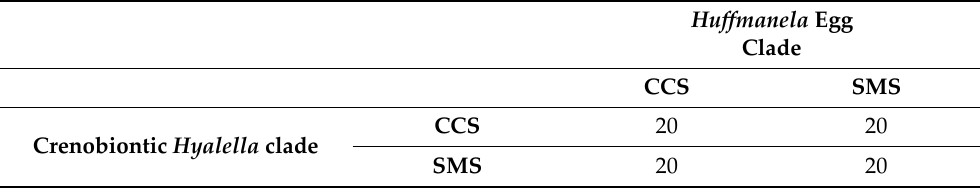
Table 4. Setup of differential mortality experiment to test for evidence of long‑term genetic isolation and coevolution of the SMS and CCS Hyalella / Huffmanela host/parasite systems. Values represent number of Hyalella amphipods from the side‑indicated spring being challenged with a heavy dose of Huffmanela eggs from the top‑indicated